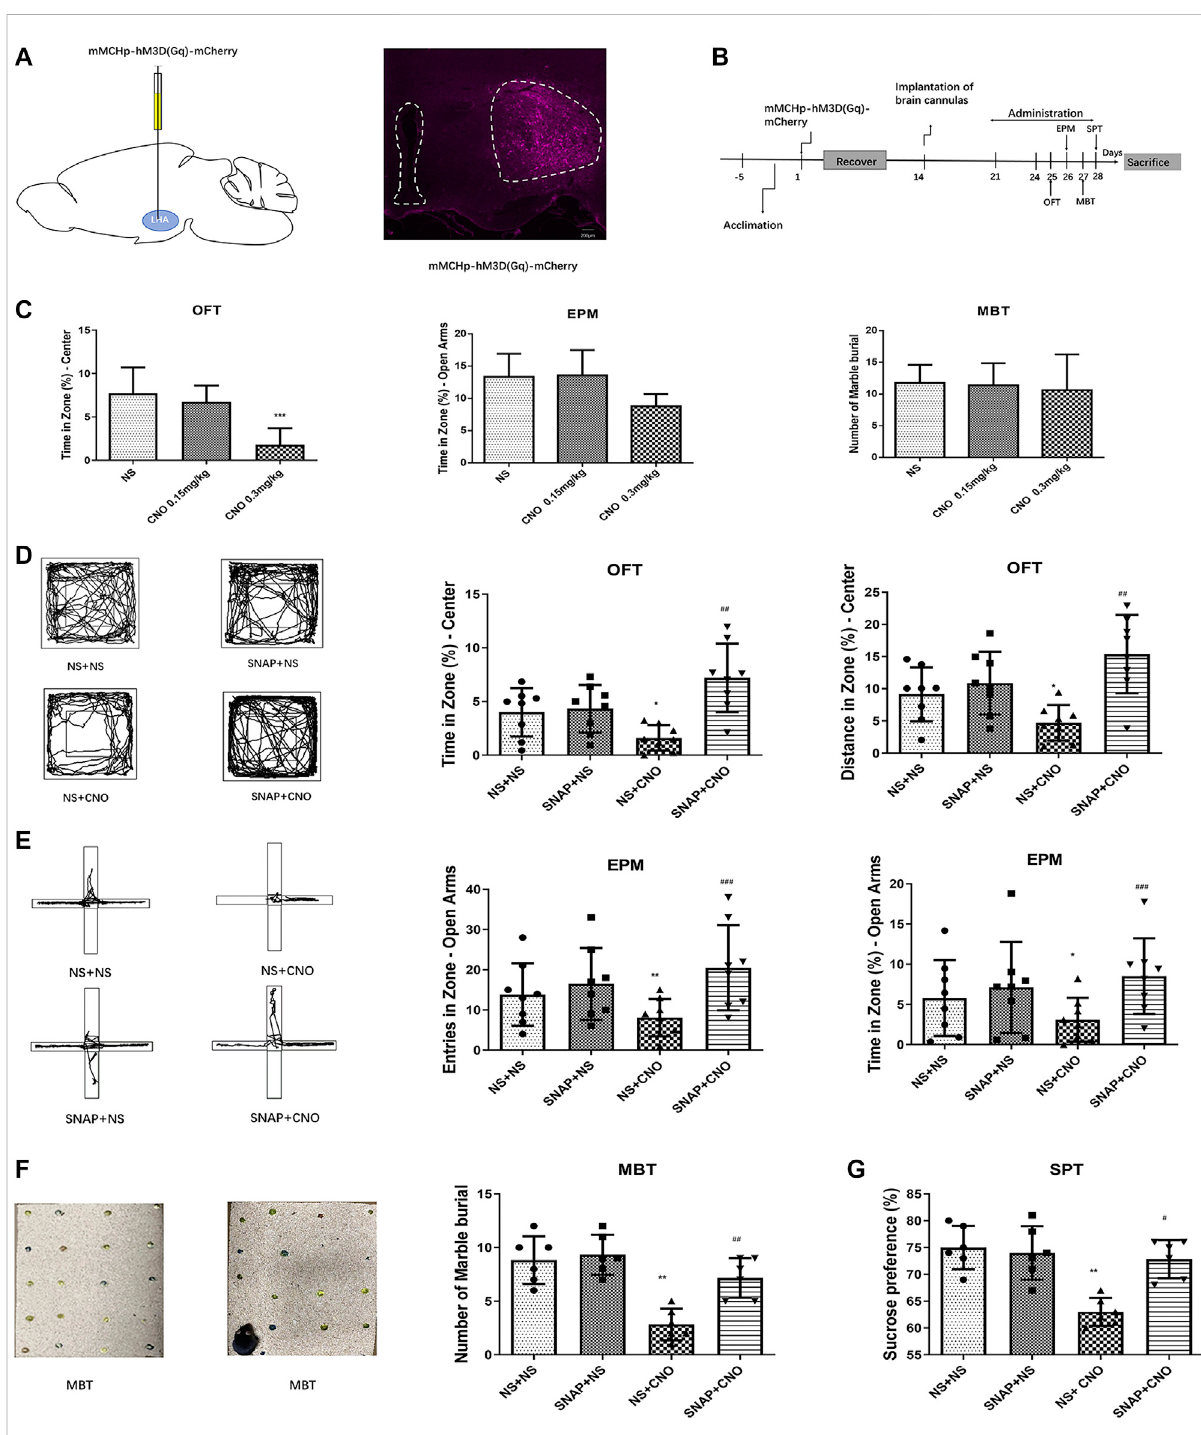
FIGURE 3 Chemogeneticactivation ofMCHneuronsinducedanxiety-likebehaviorsinmice. (A) AschematicdiagramofanmMCHp-hM3D(Gq)-mCherry injection into the LHA (left) and a representative photograph of mMCHp-hM3D(Gq)-mCherry fl uorescence at the injection site in the LHA (right). (B) An experimental procedure to activate the virus during behavioral experiments. After the mice had acclimated to the environment, the virus was injected into the LHA, with a cannula buried in the BLA; one week after their recovery from the surgery, the virus was activated by an intraperitoneal injection of CNO, and the MCHR1 blocker SNAP was injected into the BLA to measure the behavior of the mice. (C) Effects of 0.3 mg/kg and 0.15 mg/kg CNO on OFT, EPM and MBT in wild type mice. ( n = 6 – 8 mice per group). (D,E,F,G) Representative traces of locomotor activity in the OFT (D) , EPM (E) , and MBT (F) (left), the effects of BLA injection of the MCHR1 blocker SNAP and intraperitoneal injection of CNO to activatethevirusontheOFTcenterresidencetimeanddistance (D) ,EPMopenarmentrytimesandresidencetime (E) ,thenumberofmarblesburied in the MBT (F) , and sucrose preference (G) (right). The data are presented as the mean ± SEM ( n = 6 – 8 mice per group). * p < 0.05, ** p < 0.01, *** p < 0.001 versus the NS + NS group, # p < 0.05, ## p < 0.01, ### p < 0.001 versus the NS + CNO